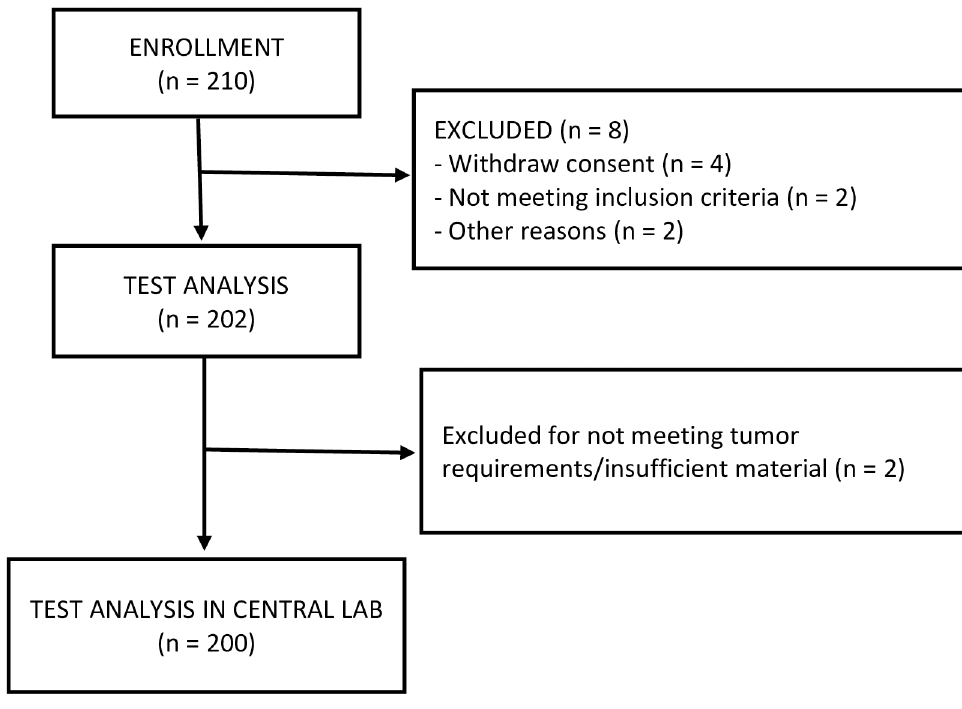
Fig 1. Patient flow diagram.